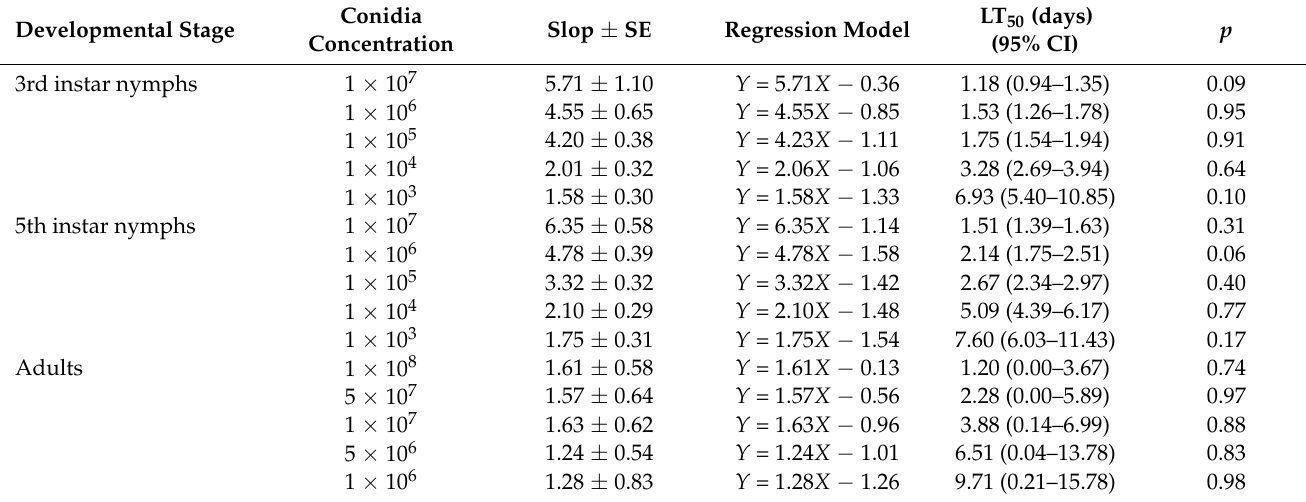
Table 3. Pathogenicity regression equations for LT 50 values of C. fumosorosea against D. citri